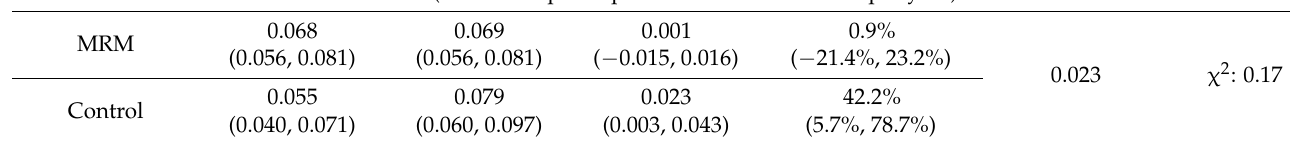
ADEs (fraction of participants with at least 1 ADE per year):